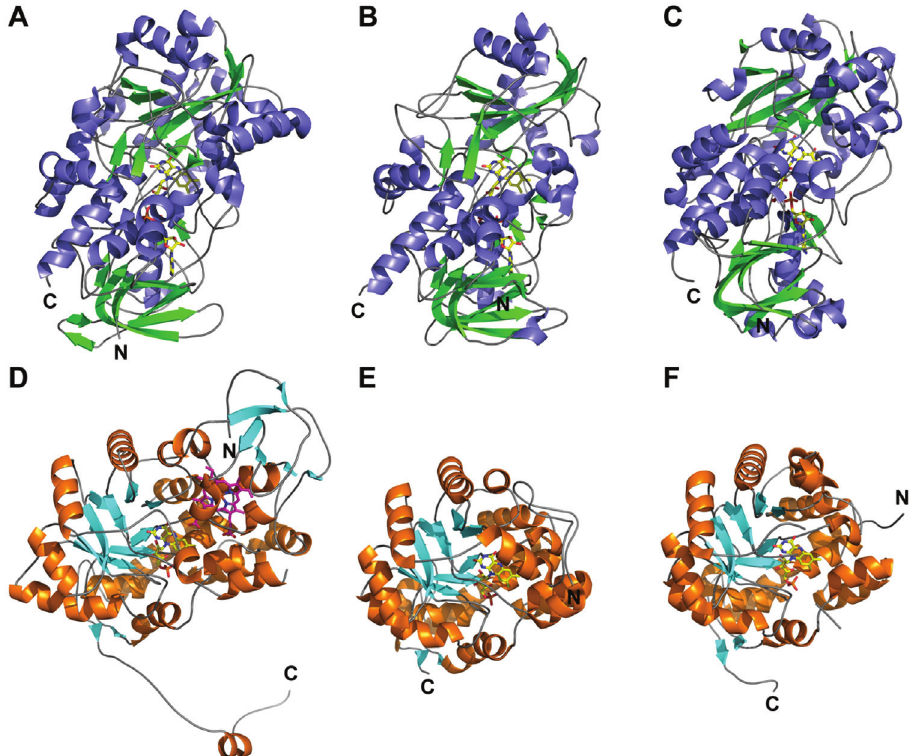
Figure 1 Structure of representative members of the GMC oxidoreductase superfamily (A–C) and the LHAD family (D–F). Pe AAO (A), Ag CHO (B), flavin-containing domain of Pc CDH (C), Sc FCB2 (D), Hs GOX (E), and Av LOX (F) (PDB codes: 3FIM, 4MJW, 1KDG, 1FCB, 2RDU, and 2NLI, respectively). The flavin (A–F) and the heme b